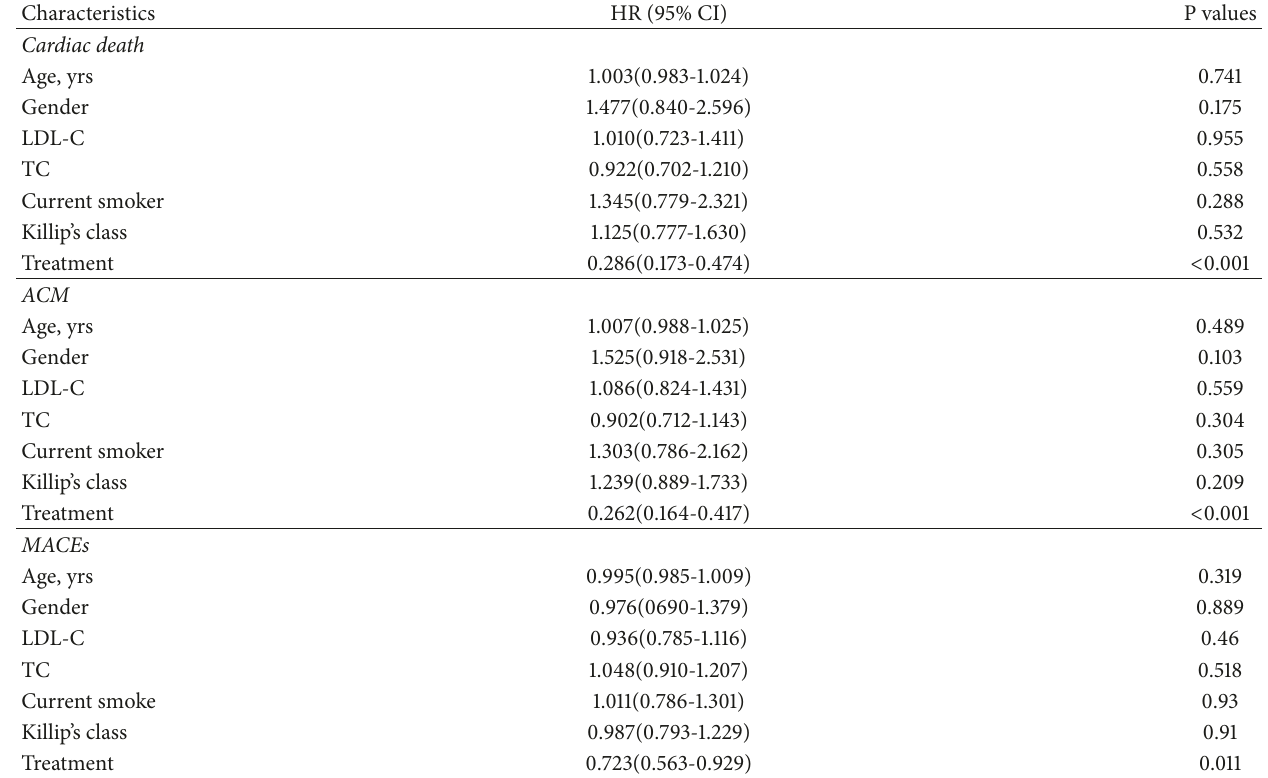
Table 3: Cox proportional hazards analysis of cardiac death, ACM, and